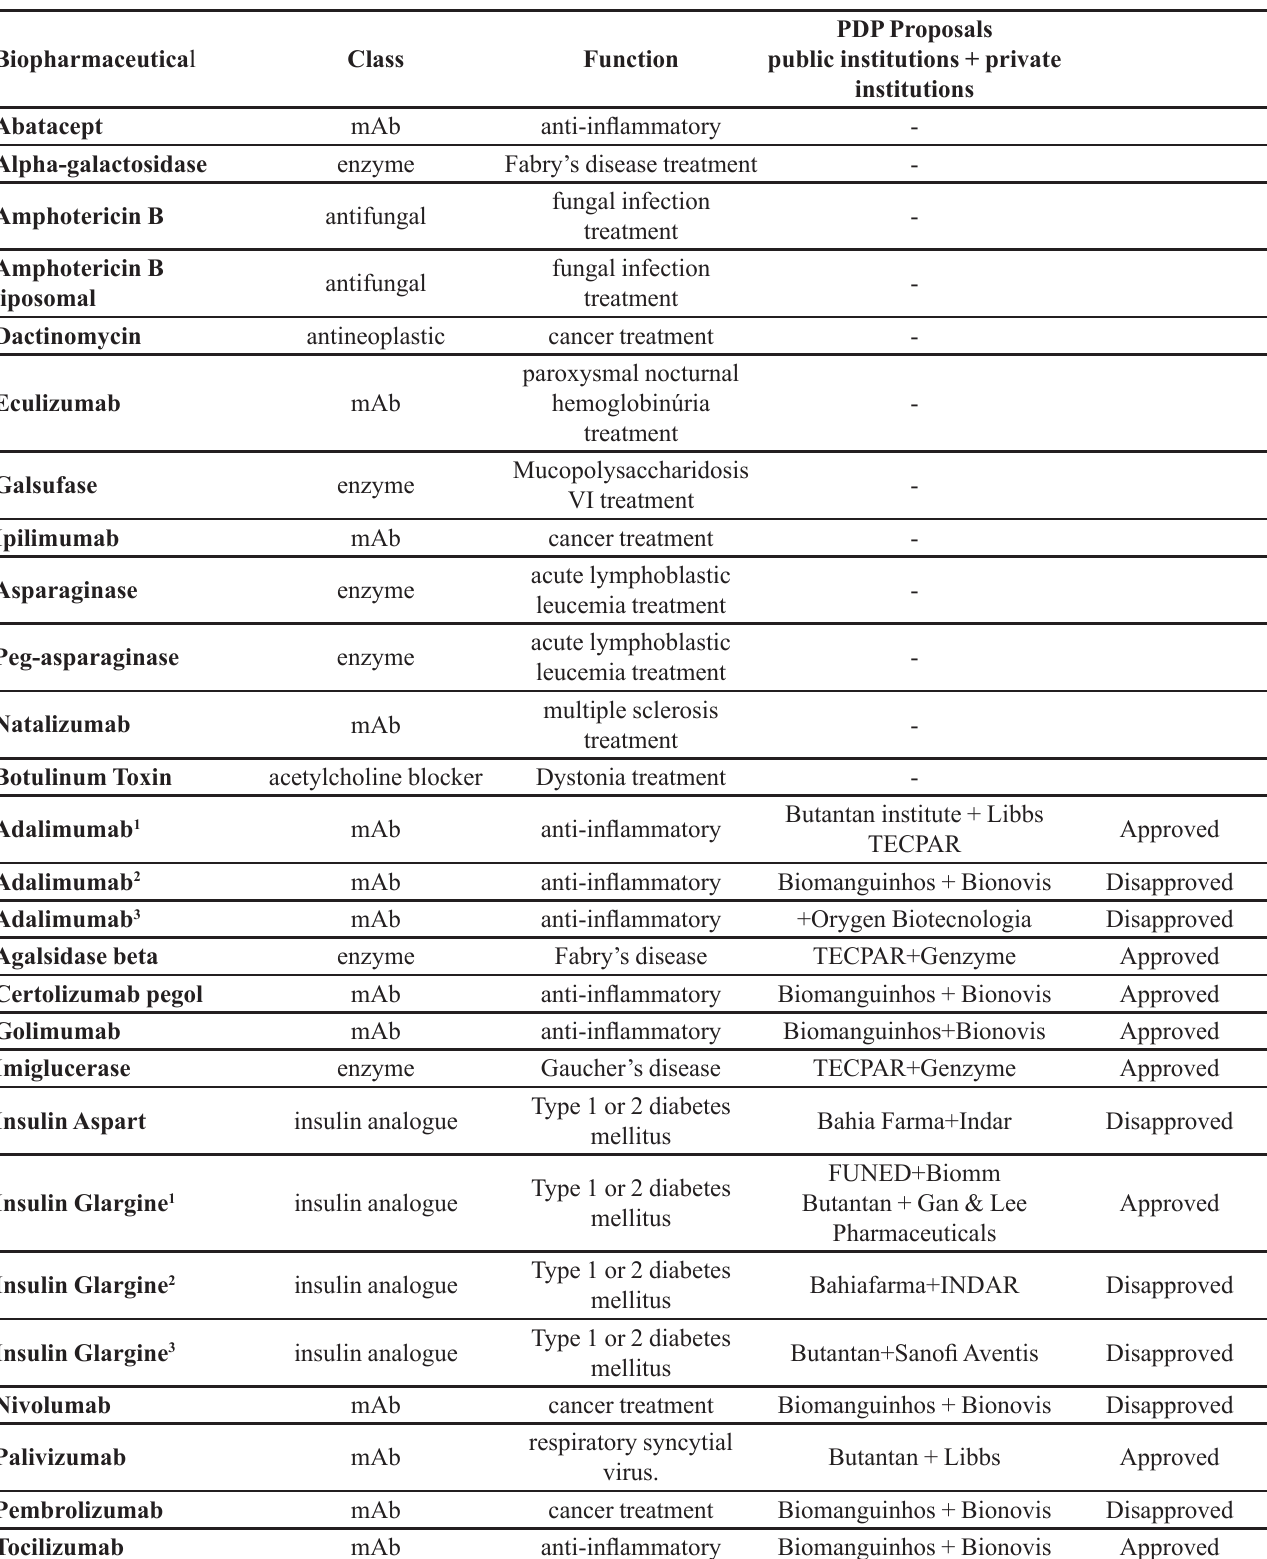
TABLE I - Biopharmaceutical in the List of Strategic Interest Products and Proposals received